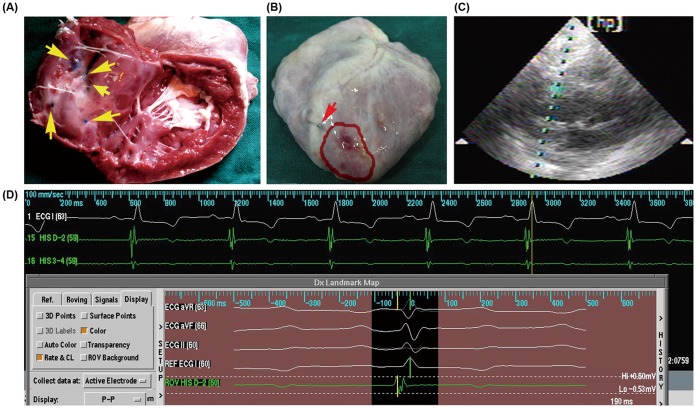
The accuracy and safety of injection.(A), (B) Representative images of methylene-blue injection. The yellow arrows pointed to injection sites, all of the sites were around the desired myocardial ischemic region (pale region). The red arrow pointed to the ligation site of the LAD. The myocardial ischemic region was marked with red curve. No MB staining was detected in the pericardium. (C) Representative image of the echocardiography. During the mapping and injection, the pericardial effusion was not detected in two groups. (D) Representative image of the surface electrocardiogram and intracardiac electrical recording. The operation did not cause malignant arrhythmia in real time.